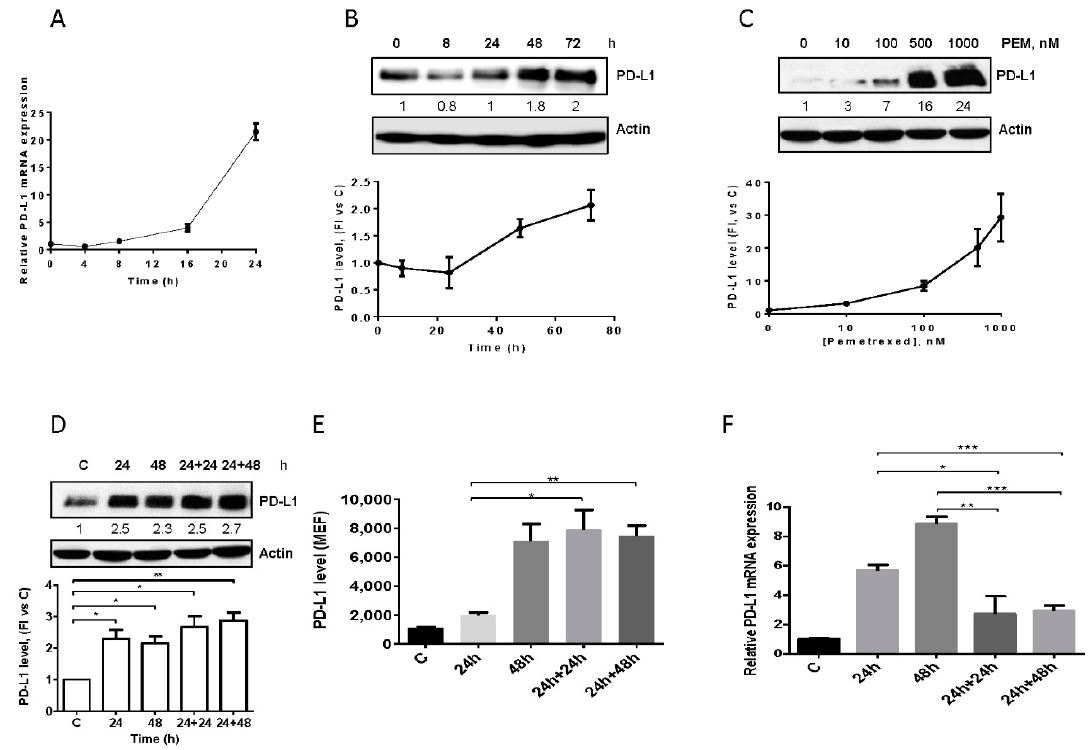
Figure 2. Effect of pemetrexed on PD-L1 expression in A549 cell line. ( A ) A549 cells were treated with 100 nM pemetrexed for the indicated period of time and PD-L1 mRNA level, evaluated by RT-PCR, was reported. ( B ) Time-dependent modulation (100 nM pemetrexed) and ( C ) dose-dependent modulation (72 h) of PD-L1 protein expression in A549 cells were evaluated by western blotting. A549 cells were continuously exposed to 500 nM pemetrexed for the indicated period of time or treated for 24 h and, after drug removal, the cells were incubated with fresh medium for 24 h or 48 h. At the indicated times, total PD-L1 protein, membrane PD-L1 protein, and PD-L1 mRNA were quantified by western blotting ( D ), flow cytometry ( E ), and RT-PCR ( F ), respectively. * p < 0.05; ** p < 0.01; *** p < 0.001. Data in ( A ), ( E ), and ( F ) are mean values ± SD of three independent experiments. Results in ( B – D ) are representative of three independent experiments.